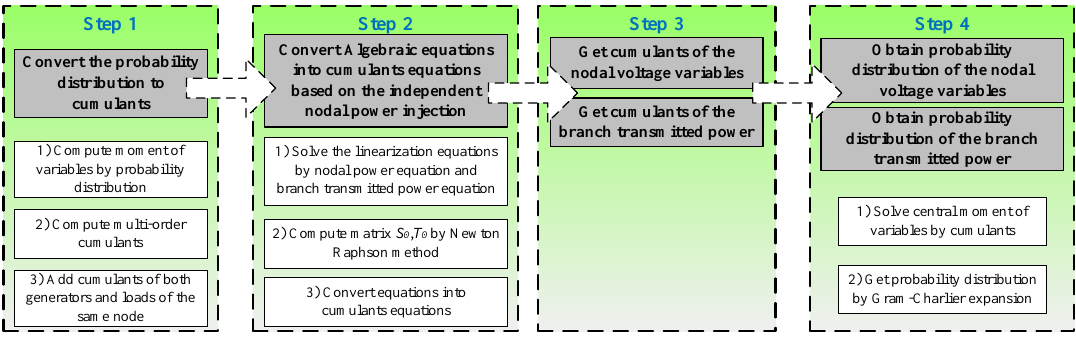
Figure 1. Block diagram for the traditional probabilistic load flow (PLF) algorithm.